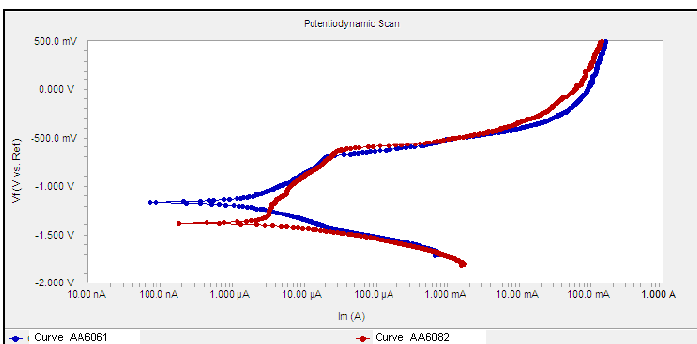
Figure 11: Polarization curves of base metals AA6082 and